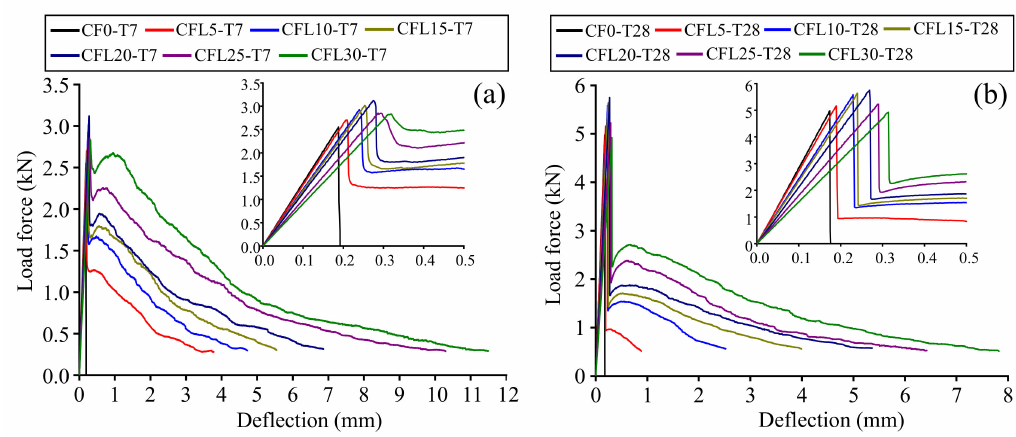
Figure 5. L-D curves: ( a ) T7; ( b ) T28.